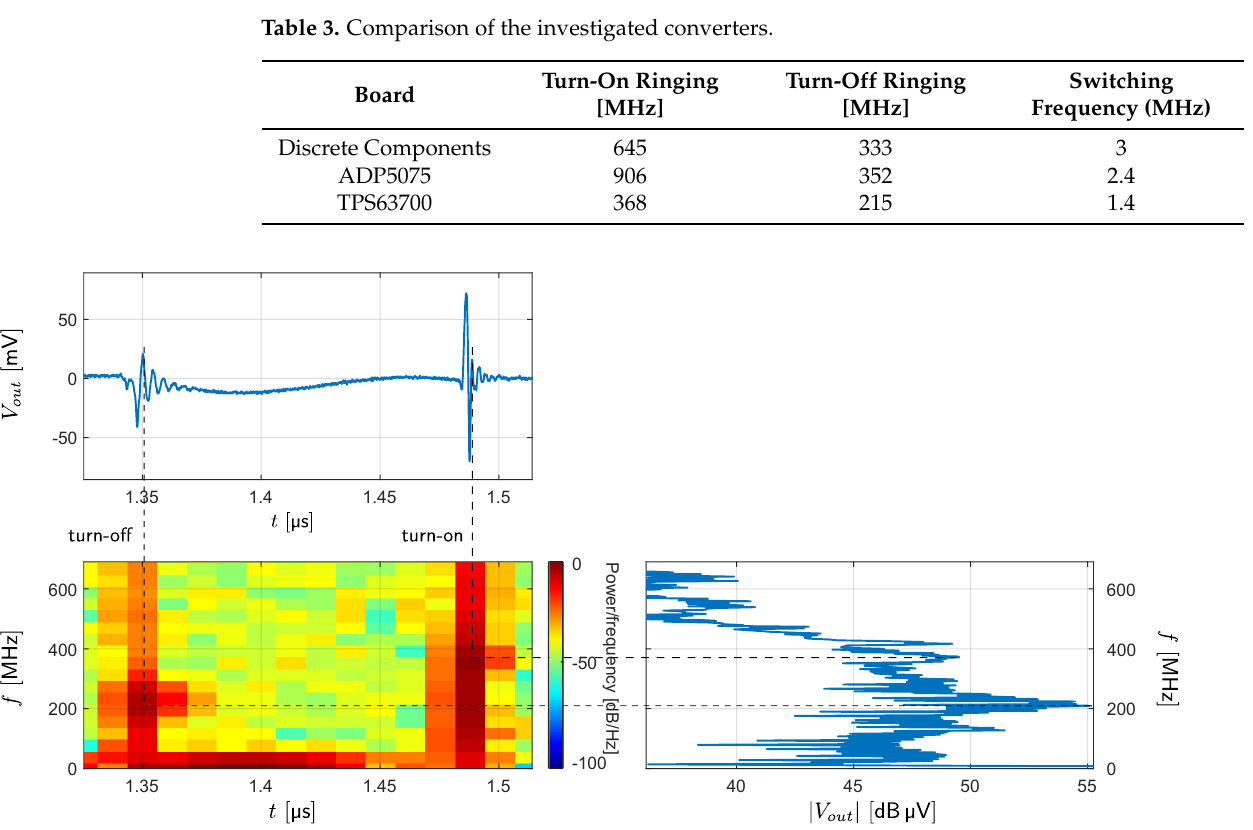
Figure 17. Measured EMI on the output port LISN using TPS63700 at 3.7V input, − 12V output, and